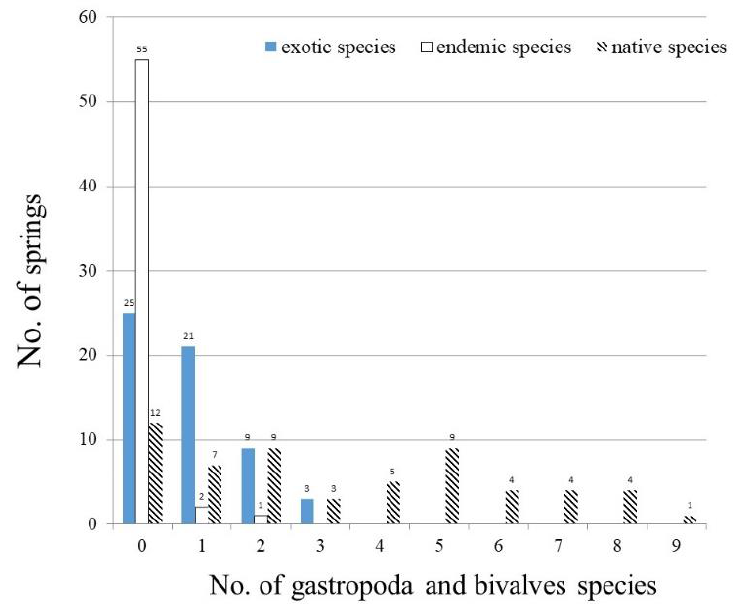
(Figure 4). Among the 46 springs, 24 gastropoda (22 species) and bivalves (two species) of 11 families were sampled (Table 5). Among the 24 gastropoda and bivalve species, four exotics (16.6%) and 20 natives (83.3%), including two endemics, were recorded. Native species appeared in 46 springs; endemic species were found in 3 springs; and exotics were present in 33 springs. The total recorded gastropoda and bivalve species of the springs varied between 0 to 12 species with a mean of 4.1 ± 3.4 species (Table 4).